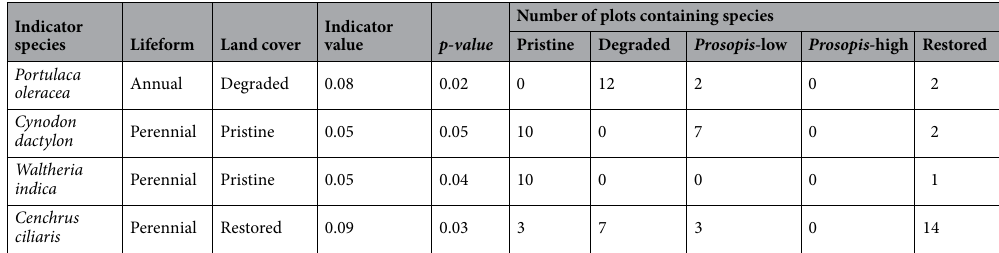
Table 2. Indicator species for three land cover types, indicator value and number of plots containing species in the five land cover types. Significance level ( α =